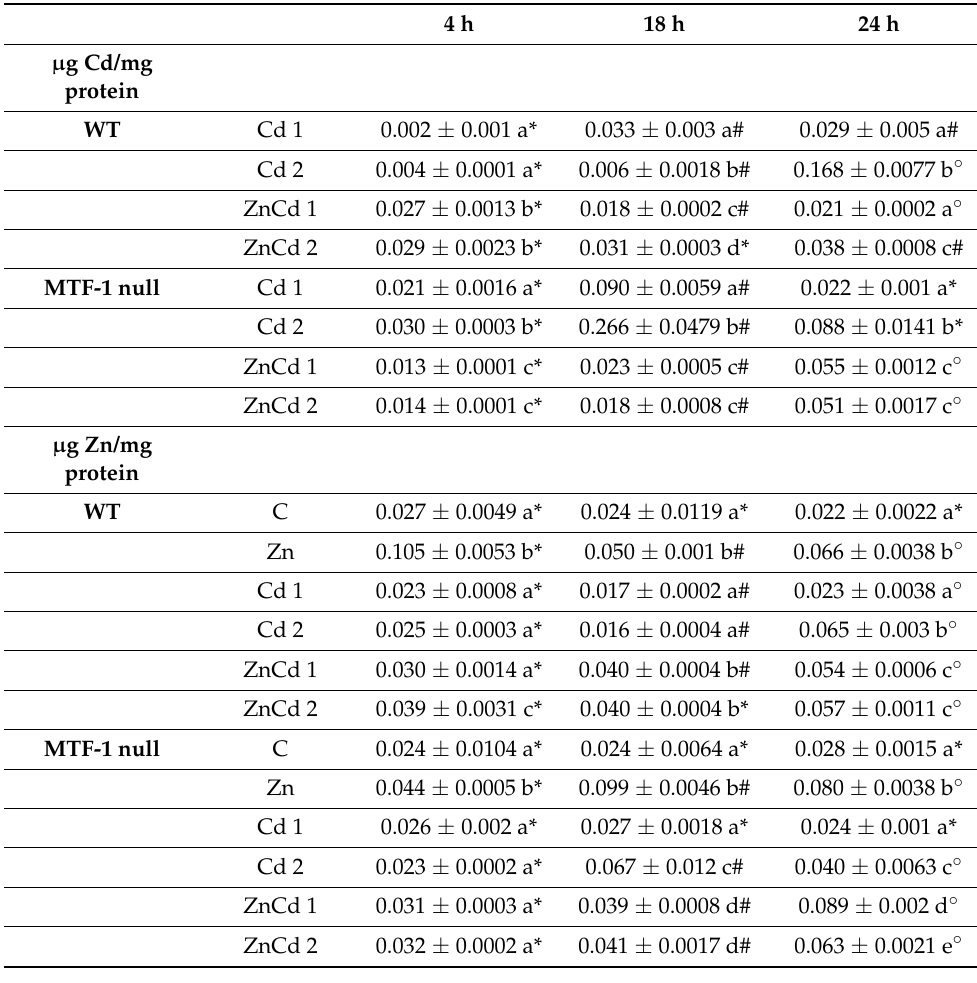
Table 1. Cd and Zn content ( µ g/mg protein) for the various treatments and times. Different letters indicate statistically significant differences between the various treatments of the same time, while the symbols indicate statistically significant differences between times within the same